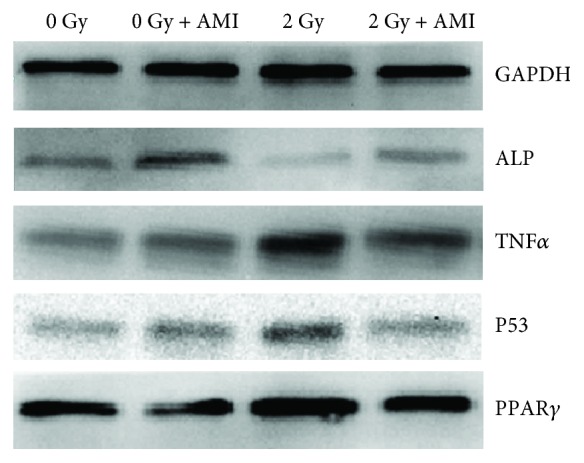
Western blot analysis. The effect of AMI and 2 Gy radiation on the protein expression of ALP, PPARγ, TNFα, and P53, as measured 5 days after radiation.